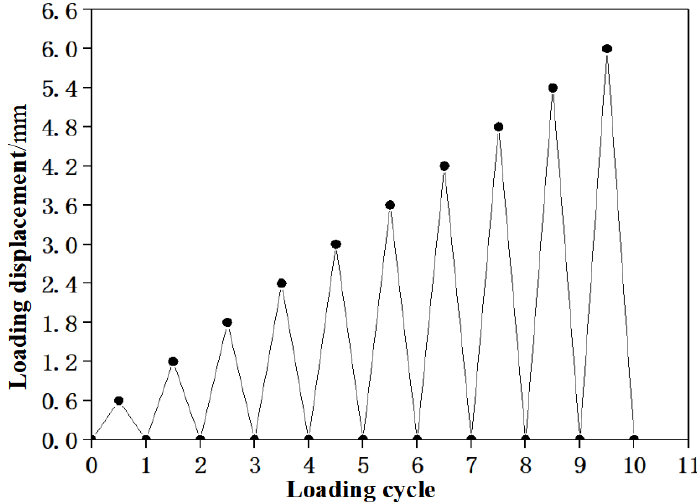
Figure 8. The loading process diagram.